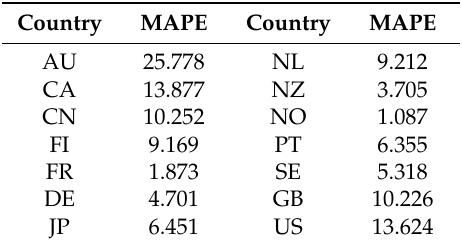
Table 10. Mean absolute percentage.